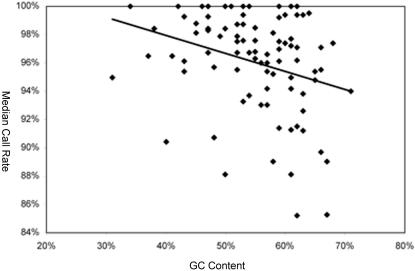
Relationship between GC content and call rate.The median call rate of each fragment across all microarrays is plotted against the GC content of each fragment.